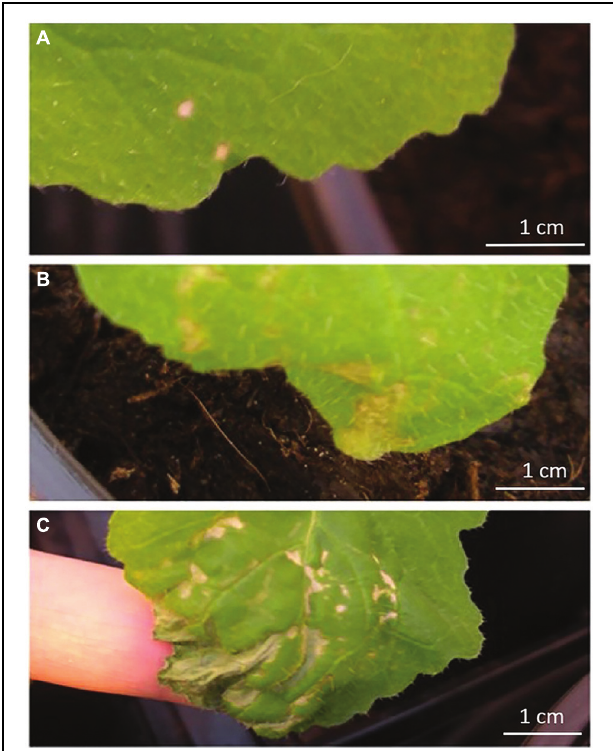
FIGURE 2 | Different severities of HR-like necrosis after application of ARG homogenate or anti-aphrodisiac compounds. Surface area of necrotic tissue and intensity of necrosis was assessed using a relative scale: (A) weak (HR + ): no or little necrotic tissue on upper leaf side, (B) medium (HR ++ ): larger parts of treated area with brownish necrotic tissue on upper leaf side, and (C) strong necrosis (HR +++ ): almost whole treated area necrotic on both sides.